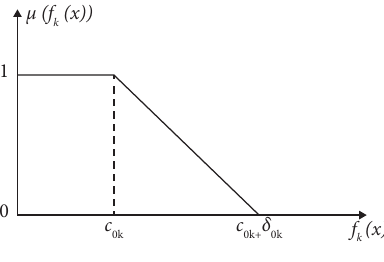
Figure 2: Satisfaction